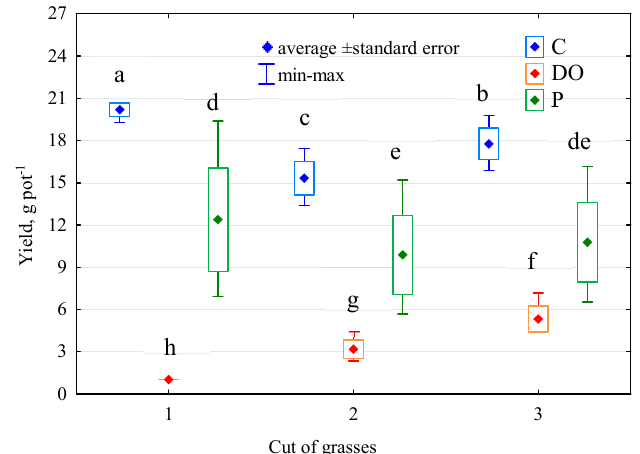
Figure 8. Yields of Elymus elongatus in cuts number 1, 2 and 3 (g DM pot − 1 ). Homogeneous groups denoted with letters (a–h) were calculated for yield.